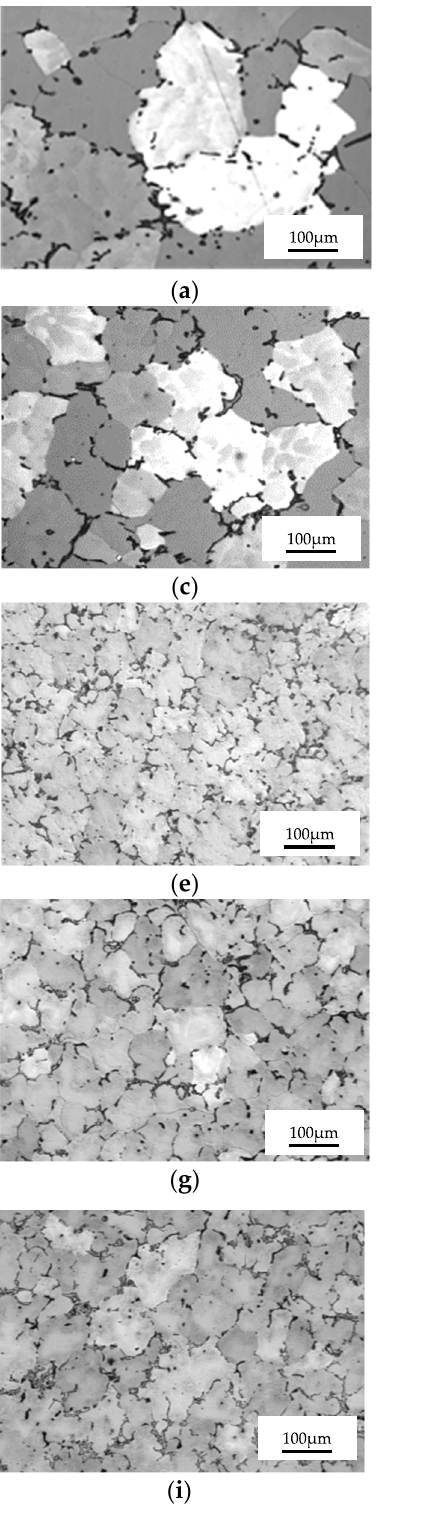
Figure 6. Structural analysis of cast experimental samples from aluminum 5083 alloy: ( a ) Gauge sample (H), ( b – d ) cast + quenched at 350 ° C/100 min/air + artificial ageing at 180 ° C; ( e – g ) cast + quenched at 450 ° C/100 min/air + artificial ageing at 140 ° C; ( h – j ) cast + quenched at 450 ° C/100 min/air + artificial ageing at 140 ° C ( b , e , h ) 1 h maintaining, ( c , f , i ) 12 h maintaining, ( d , g , j ) 24 h maintaining . Table 3. Grain size analysis of the experimental alloy type 5083.